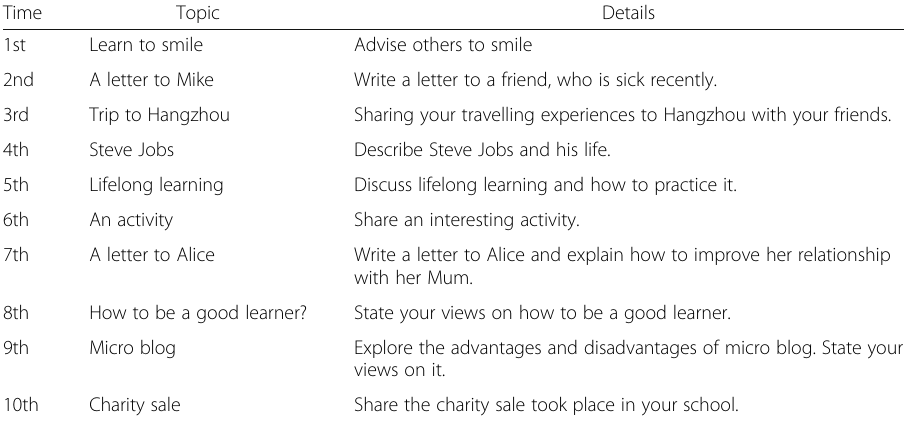
Table 1 Ten writing tasks collected for the present study Time Topic Details Learn to smile Advise others to smile